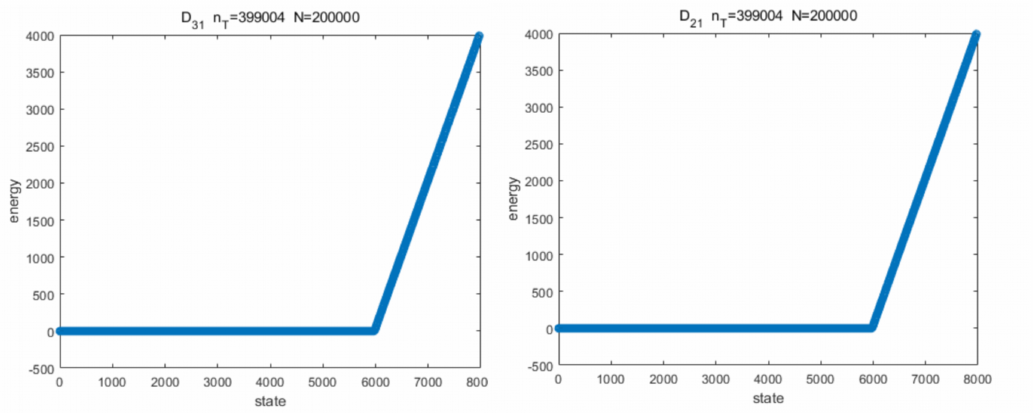
Figure 2 . The first plot is the spectrum of leading action of D 31 , while the second plot is that of D 21 . Each spectrum is calculated in the system with n T =399004 and N = 200000 . ( N, n T ) D 0 D 1 D 2